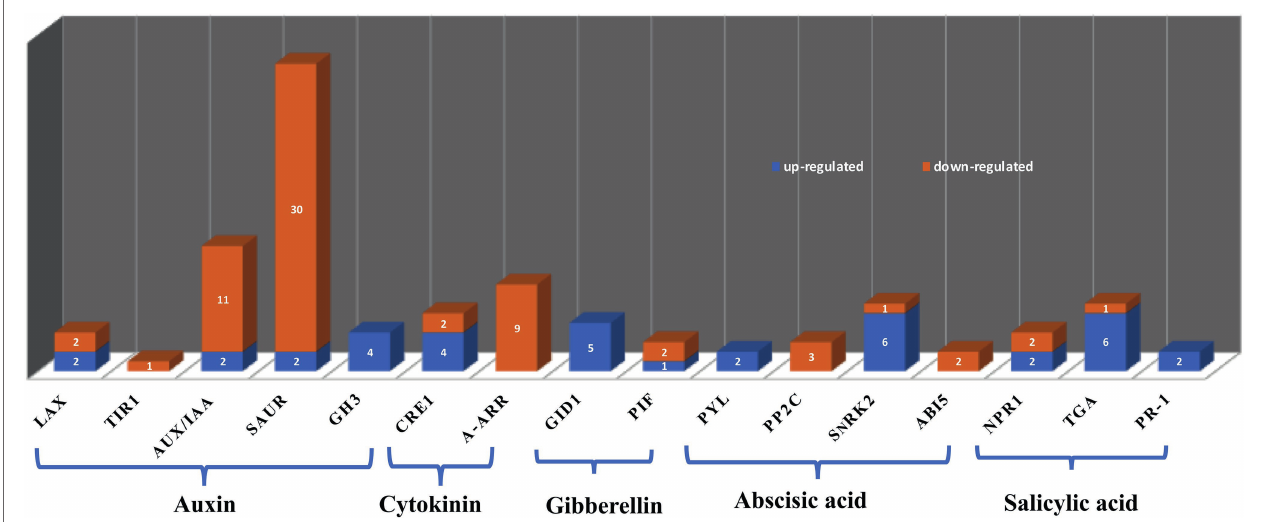
FIGURE 10 | Hormone types and associated differentially expressed genes (DEGs). The y -axis indicates number of DEGs displayed on the bars, and the x -axis shows names of DEGs. LAX: like-aux1; TIR1: transport inhibitor response protein 1; Aux/IAA: including auxin/indole-3-acetic acid; SAUR: small auxin up RNA; GH3: gretchen hagen 3; CRE1: cytokinin receptor 1; A-ARR: type-A authentic response regulator; GID1: gibberellin-insensitive dwarf 1; PIF: phytochrome-interacting factor; PYL: pyrabactin resistance 1-like; PP2C: clade A protein phosphatases type-2C; SnRK2: sucrose non-fermenting 1-related subfamily 2; ABI5: abscisic acid- insensitive 5; NPR1: nonexpresser of PR gene 1; TGA: TGACG sequence-specific binding proteins; PR-1: pathogenesis-related protein